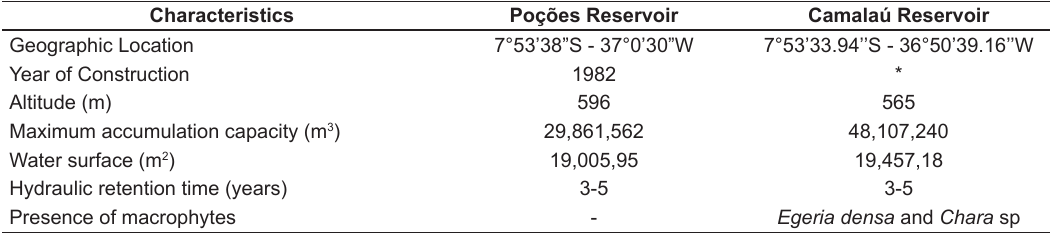
Table 1. Characterization of Poções and Camalaú reservoirs, Paraíba River basin, State of Paraíba, northeastern Brazil. Source: Executive Agency of Water Management of the State of Paraíba (AESA,